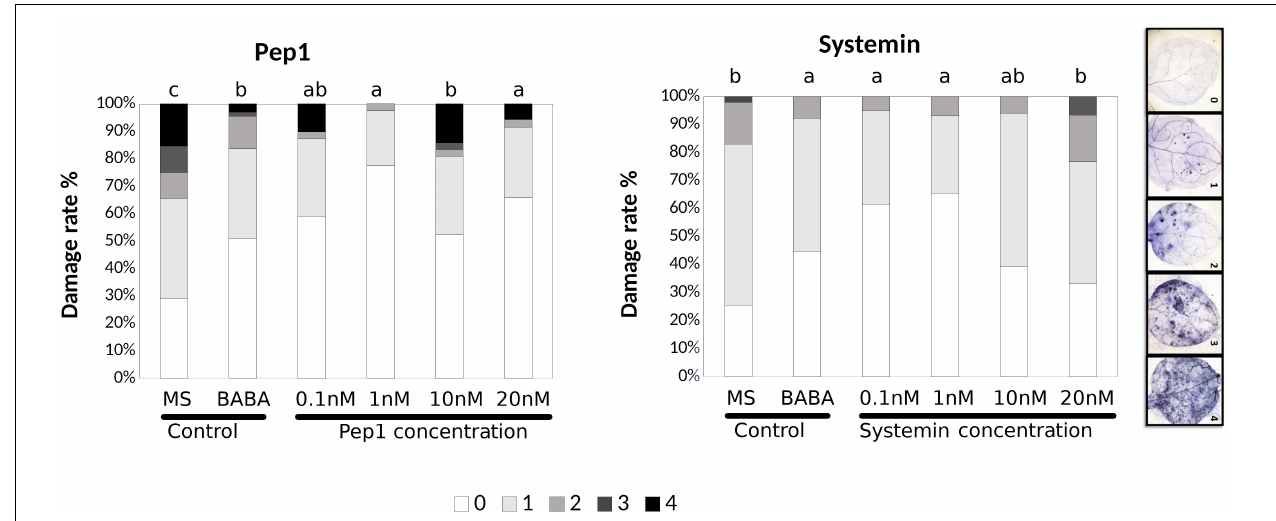
FIGURE 1 | Pep1 and Systemin induced-resistance assays against Plectosphaerella cucumerina in Arabidopsis plants. Infection levels 5 days after inoculation quantified by a disease rating in trypan blue stained leaves, measured as a percentage of the infected leaf surface. Arabidopsis Col-0 plants were treated with increasing concentrations of Pep1 or Systemin (0.1, 1, 10, and 20 nM) 24 h before infection with 1 µ l droplets of 5 × 10E3 spores/ml of P. cucumerina BMM. ß-amino butyric acid (BABA) at 1 ppm was used as a positive control. Colors mean % of diseased leaves in a scale (0 = healthy leaves; 1 = leaves with less than 25% of diseased surface; 2 = leaves with 25–50%; 3 = leaves with 50–75% of the diseased surface, 4 = leaves with more than 75% of the surface diseased). Different letters indicate statistically significant differences (ANOVA, Fisher’s Least Significant Difference (LSD) test; P < 0.05, n = 24). The experiment had 6 plants per treatment and was repeated at least three times with similar